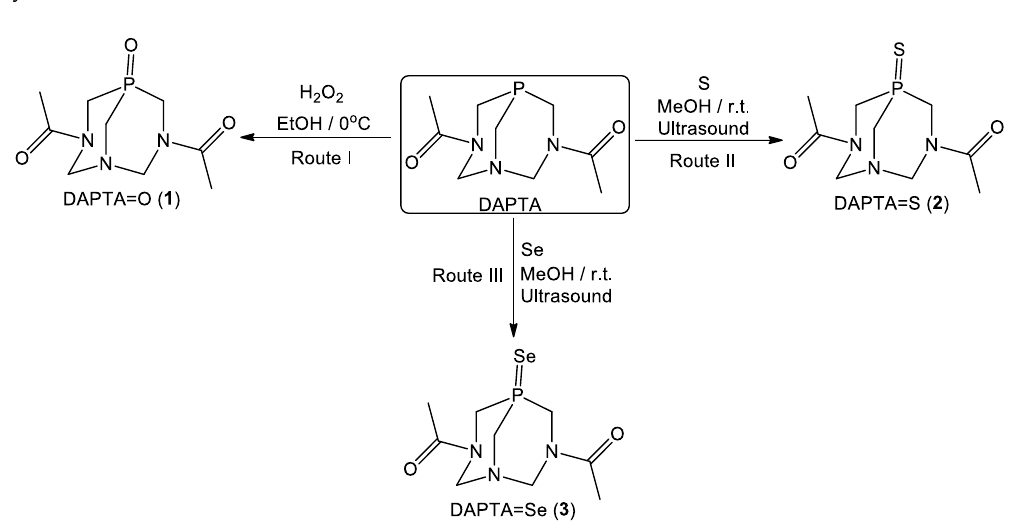
Figure 3. 31 P{ 1 H} NMR spectrum of DAPTA=Se ( 3 ) in DMSO- d 6 (500 MHz). 31 P{ 1 H} NMR experiments were also performed in D 2 O (for compounds 1 and 2 ; Figures S3 and S6) and in CDCl 3 (for compound 3 ). In all cases, the existence of the three rotamers was confirmed by the presence of three 31 P resonances. In all cases, the 1 H NMR spectrum shows seven sets of signals arising from the ten aliphatic methylene protons, observed between 5.6 to 3.2 ppm. Their splitting patterns are traceable through the diastereotopic nature of the NC H 2 N and PC H 2 N moieties. These resonances were assigned based on COSY experiments. Figure 4 shows a comparison of the 1 H NMR spectra of DAPTA and of compounds 1 – 3 in DMSO- d 6 in the 5.7 – 3.0 ppm region. A comparison of the 31 P{ 1 H} NMR spectra these compounds in the same solvent is depicted in Supplementary Figure S9.